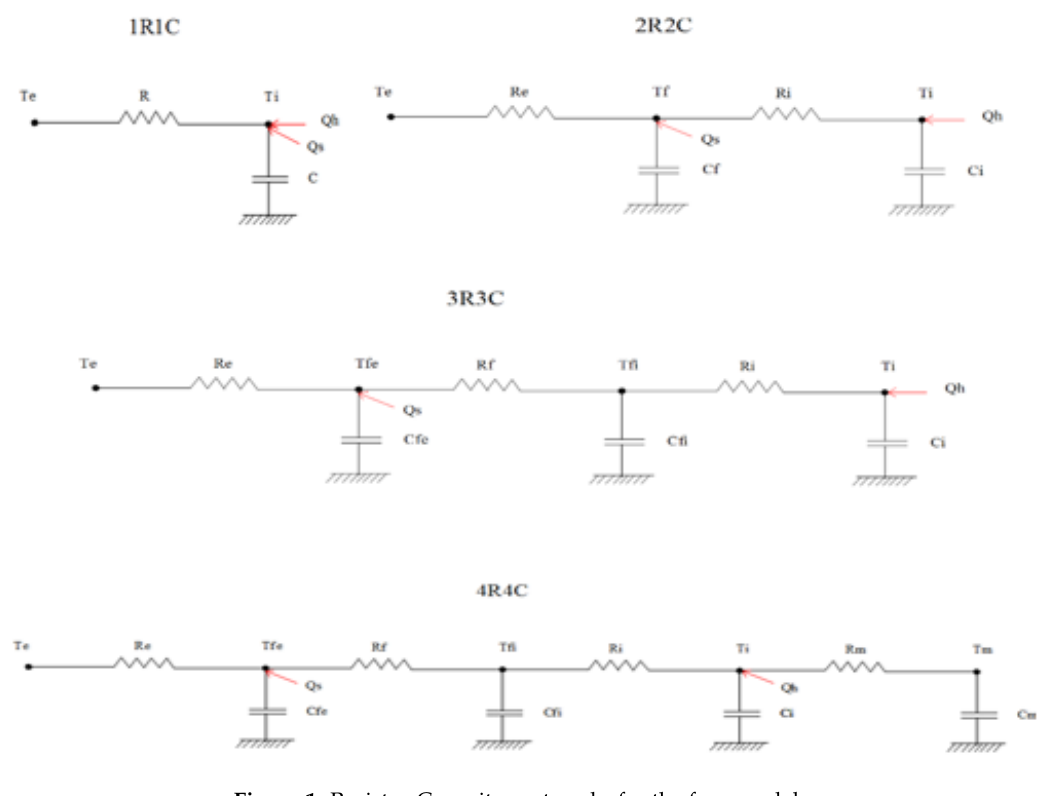
Figure 1. Resistor-Capacitor networks for the four models.